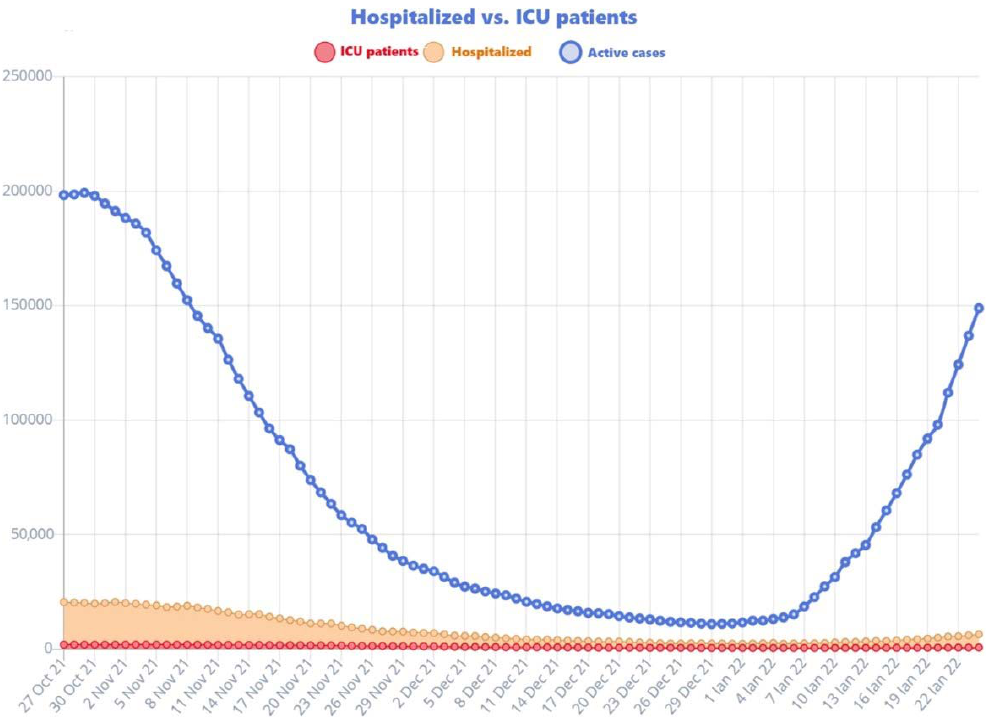
Figure 1. Representation of hospital admissions, admissions to intensive care wards and deceased during this period [10].